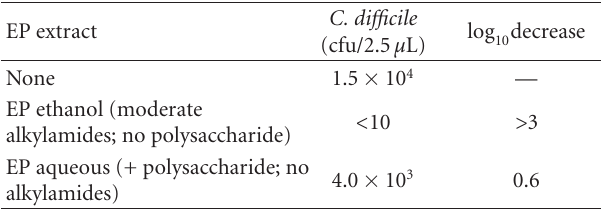
Table 8: E ff ect of EP on Clostridium di ffi cile